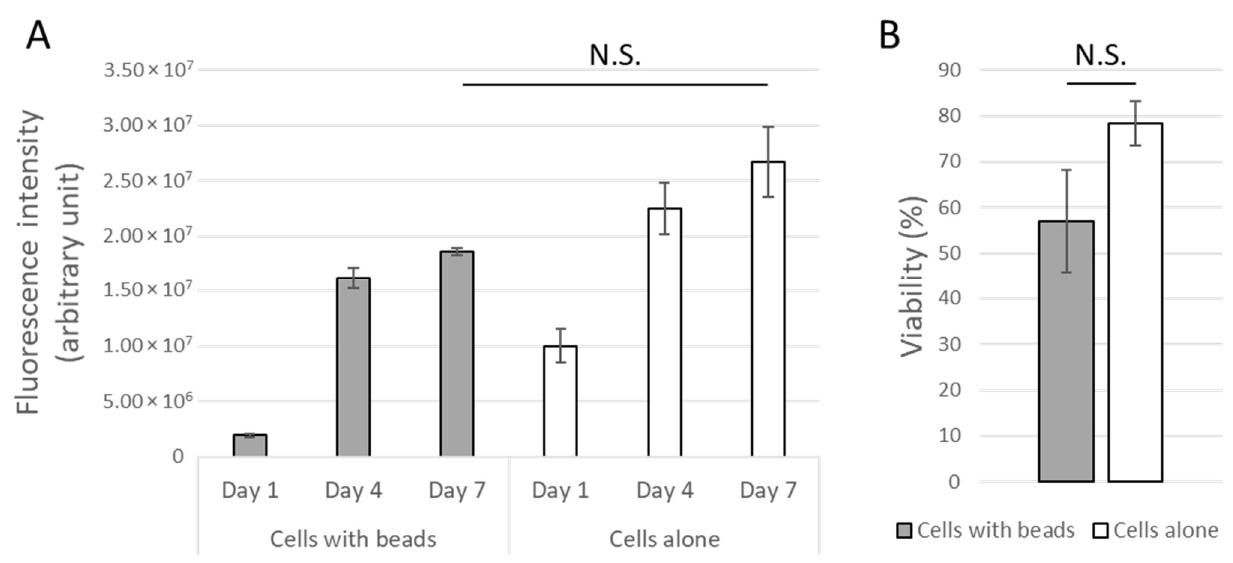
Figure 7. Metabolic activity ( A ) and cell viability ( B ) of MSCs cultured on tissue culture plastic surface with or without Fe-alginate beads dropped in the culture environment. Mean and standard error of mean. No statistical significance was found (N.S.: Non-significant ( p > 0.05)). Both groups, with or without beads, showed an increased metabolic activity over time, highlighting cell expansion (Figure 7A). Assuming that all cells from the population